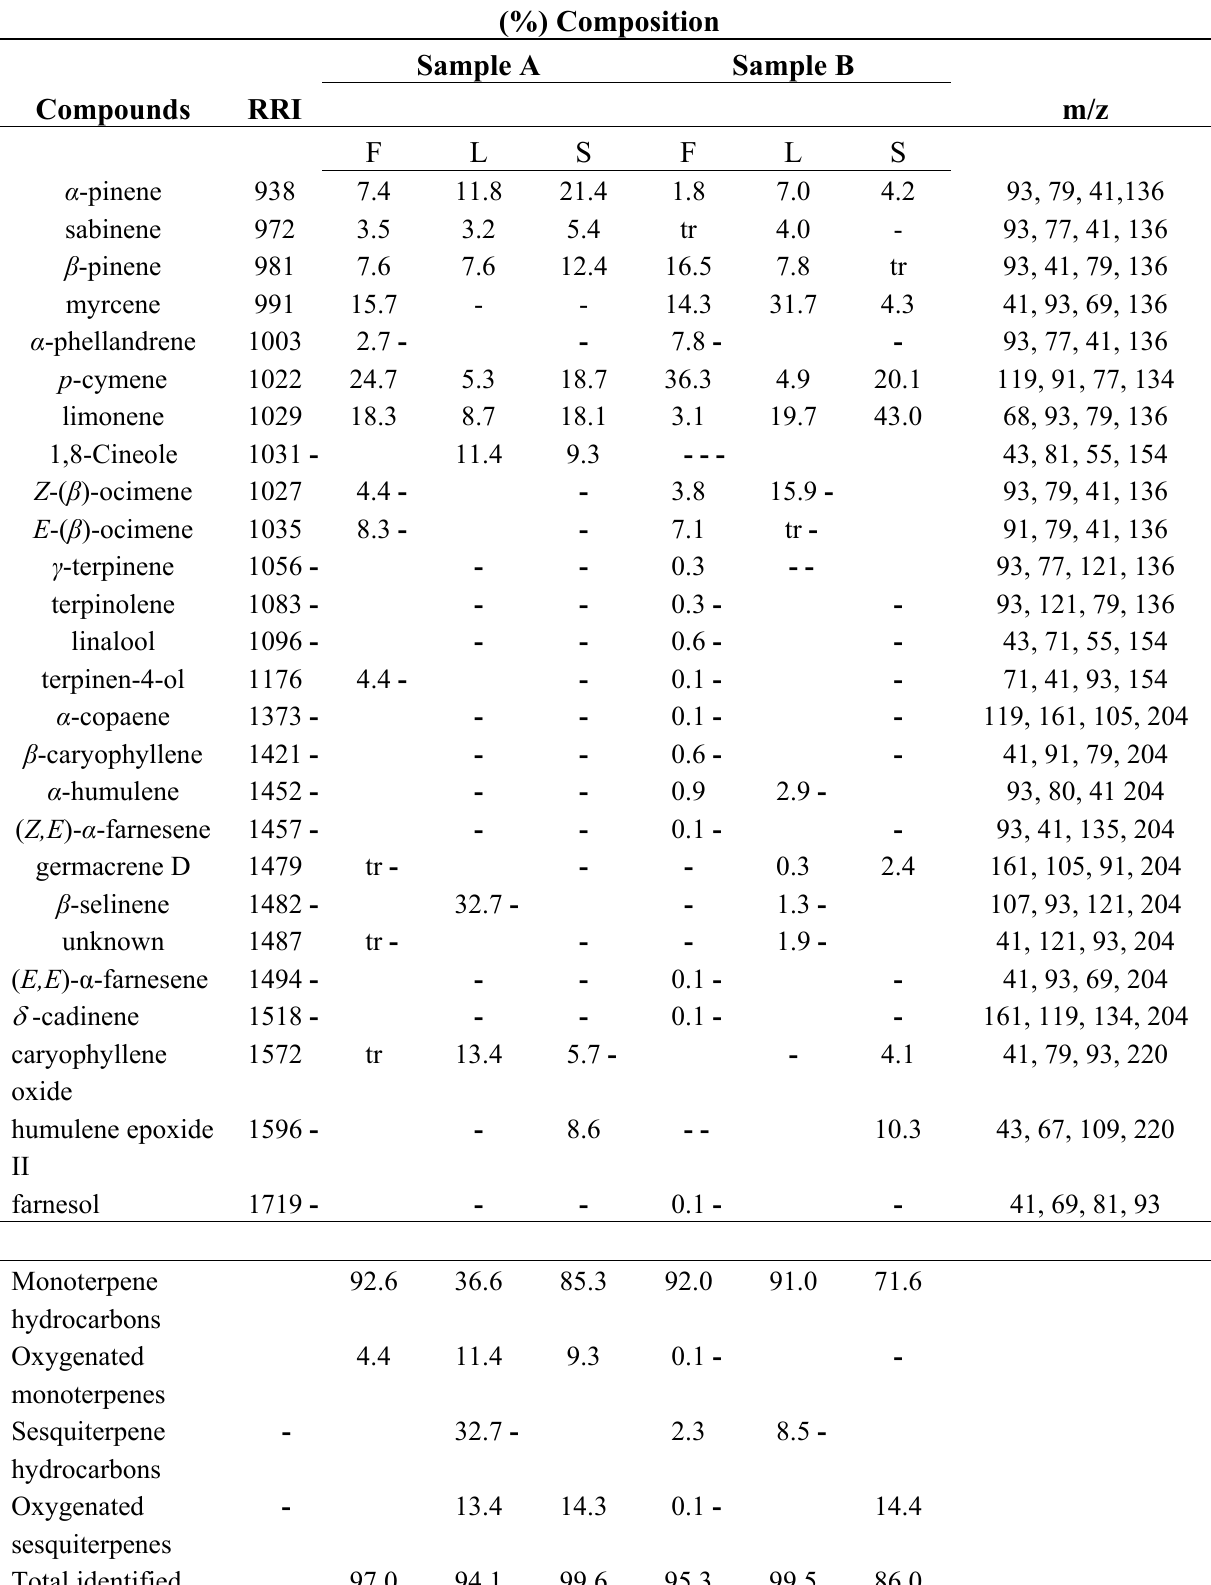
Table 2. Chemical composition of essential oil of Senecio polyanthemoides Sch. Bip. (%) Composition Sample A Sample